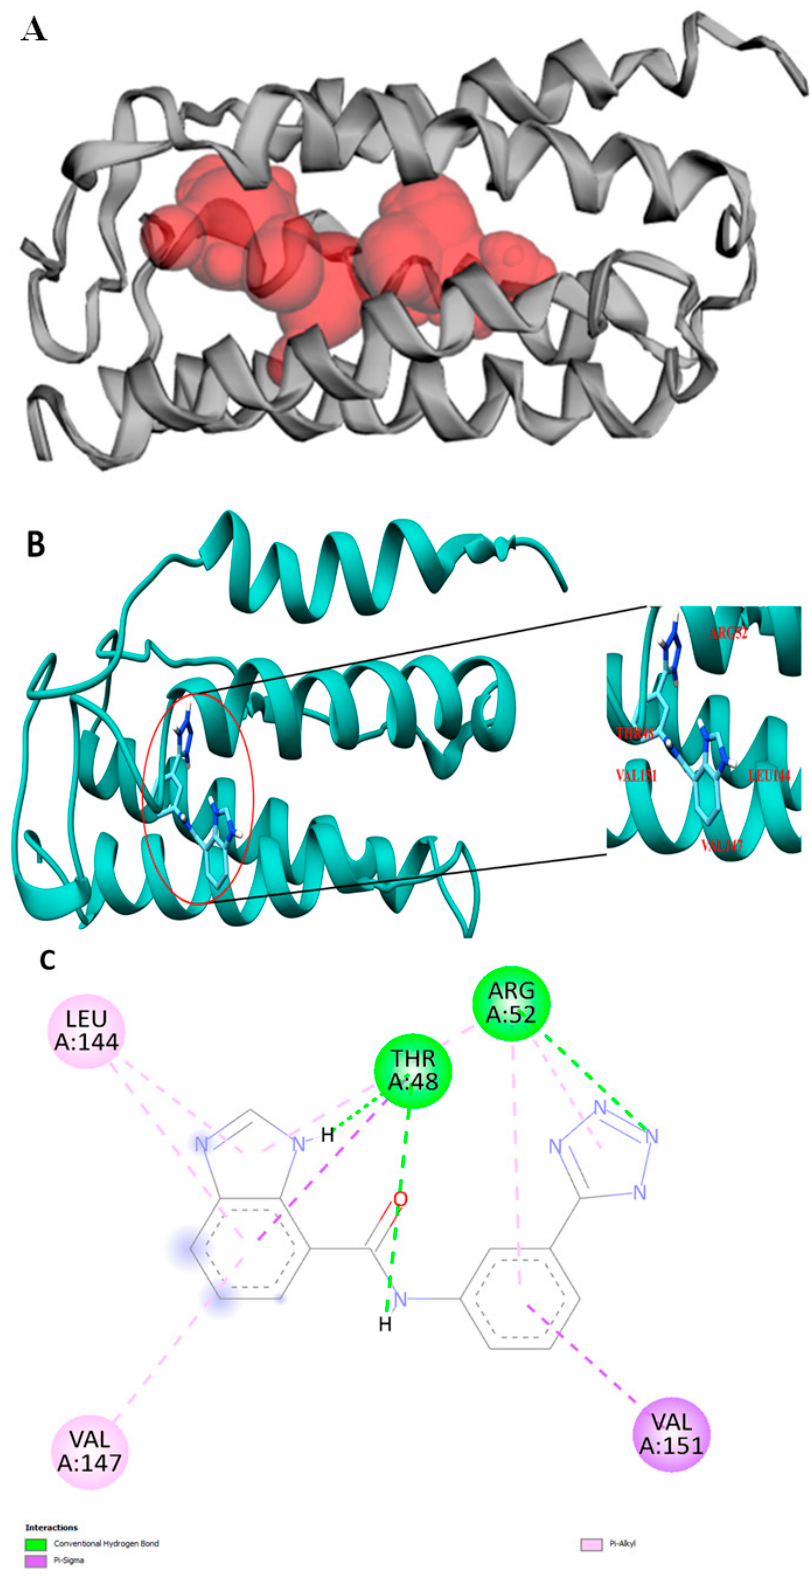
Figure 2. Docking pocket and representation of VanZ and G3K interaction. ( A ): Binding pocket predicted by CASTp. ( B ): TheVanZ–G3K docking pose. The amino acids interacting with G3K are marked. ( C ): A 2D representation showing the interacting amino acids, Arg52, Thr48, Leu144, Val147, and Val151 of VanZ with G3K ligand. Pocket prediction, docking and interaction analysis experiments were repeated three times each.